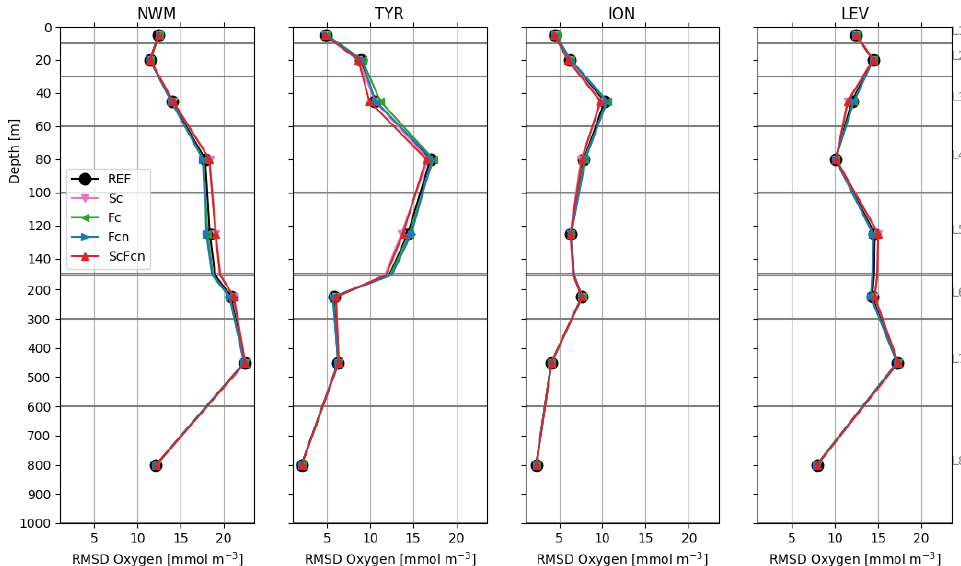
Figure 4. RMSD between model simulations and BGC-Argo oxygen data in four sub-basins (Fig. 1). Grey lines indicate the limits of layers L1–L8 (Table 2) used to calculate the RMSD. The depth scale is different above and below 150m (double grey line).